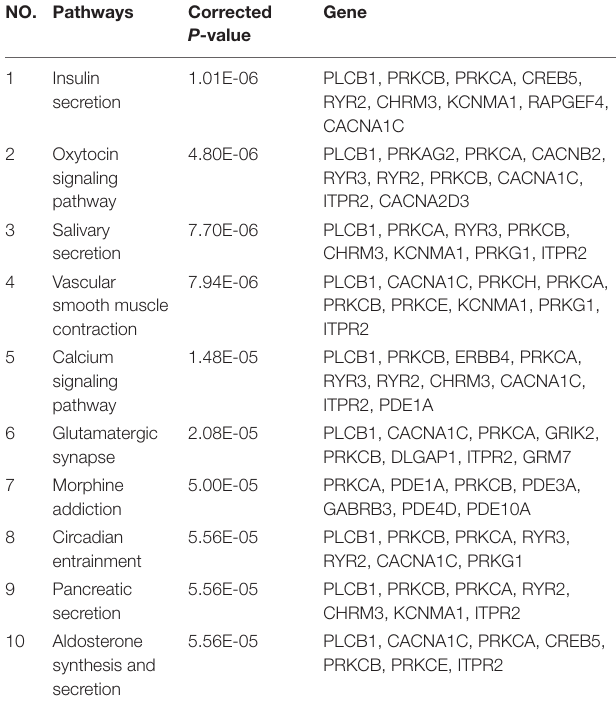
TABLE 4 | Top 10 significant